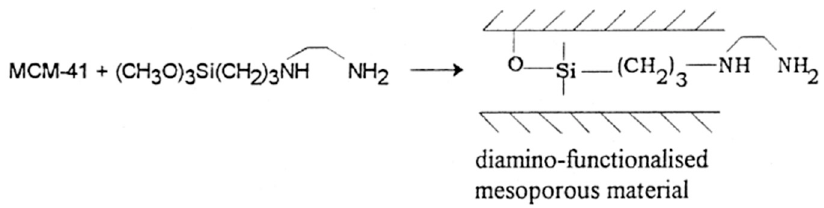
Figure 7. Preparation of diamino-functionalised mesoporous material by anchoring 3- trimethoxysilylpropylethylenediamine moiety on calcine MCM-41. Reproduced with permission